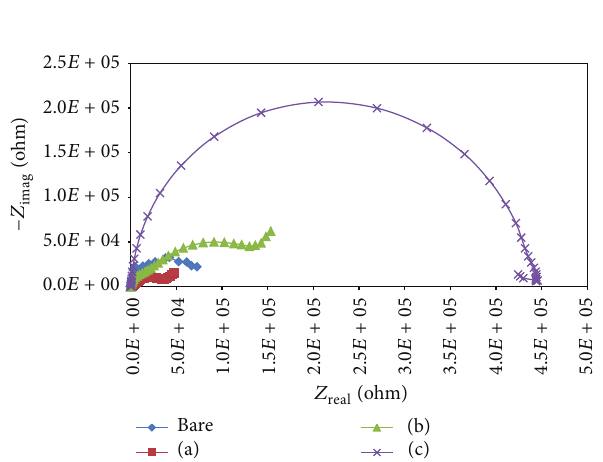
Figure 5: Nyquist plots for bare and coated samples dried at (a) 200 ∘ C (b) 400 ∘ C, and (c) 700 ∘ C, after 1 hour immersion in 3.5 wt.% NaCl